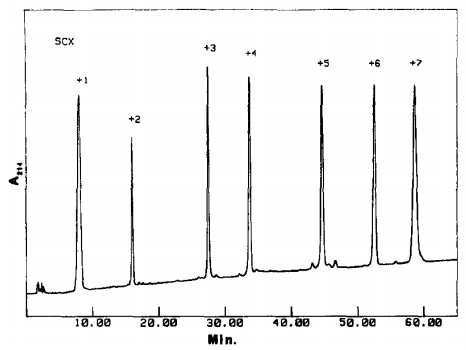
Figure 2. Separation of seven synthetic peptides bearing different charges by means of Ion-Exchange chromatography. Reproduced with permission from